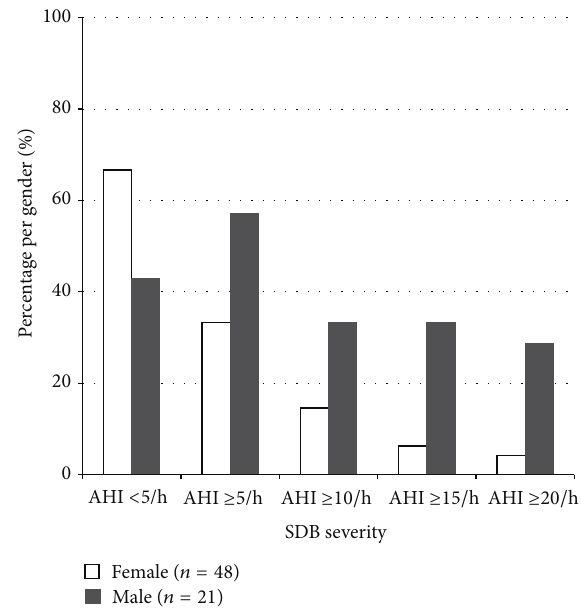
Figure 1:MaleMS patients withsevere fatiguewere morefrequently affected by SDB than female MS patients with severe fatigue.